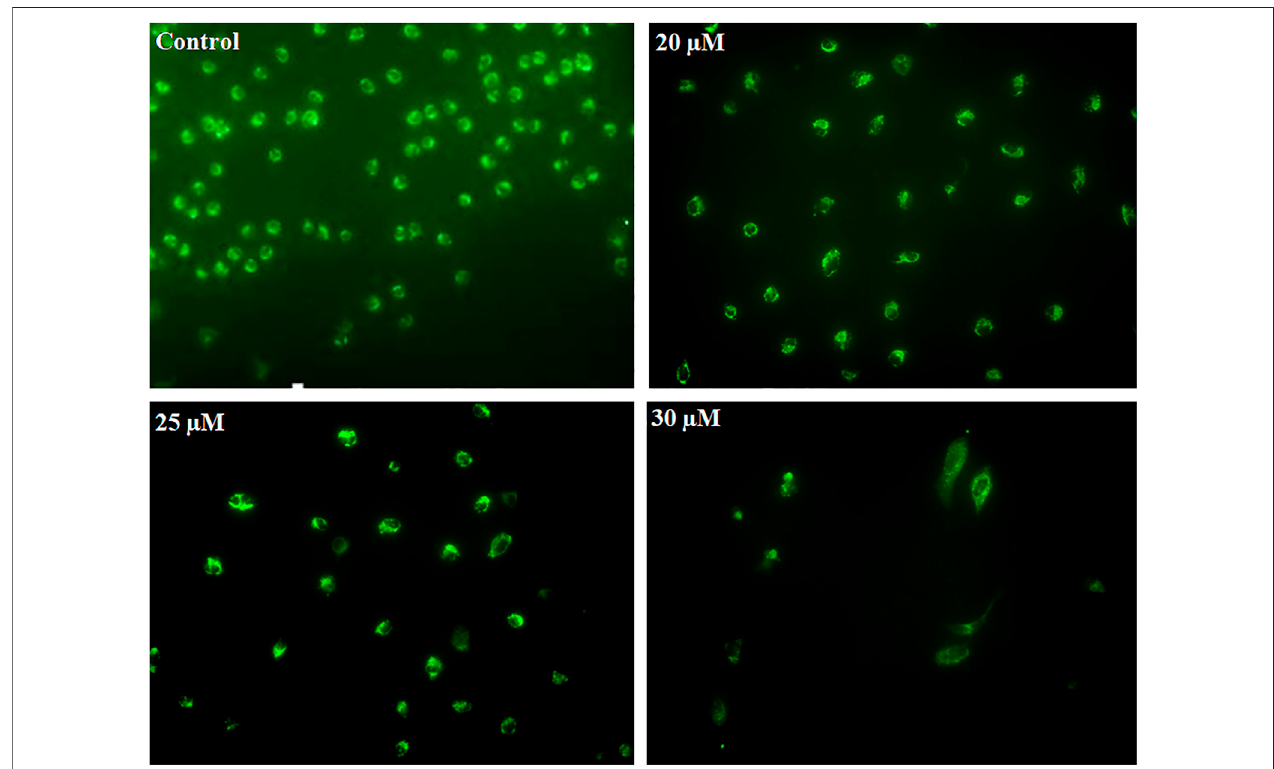
FIGURE 6 | CaSki cells were exposed to different concentration of PEITC (20, 25 and 30 μ M) for 24 h. Then, cervical cancer cells were analyzed for mitochondrial ROS generation by fl uorescence microscope using DHR123. The image is the representation of three independent experiments.